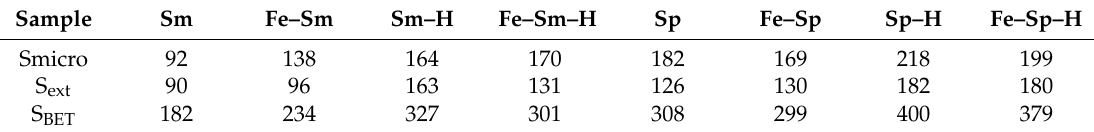
Table 2. Specific surface areas (m 2 · g − 1 ) of the natural clays and the obtained materials.